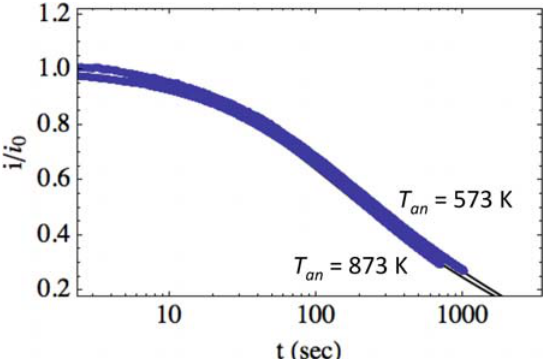
Photocurrent transient relaxation for detectors with base films annealed at T = 573 K and T = 873 K (filled circles) at illumination intensity P = 2.0 mW/cm 2 . an an Experimental data is fit to Equation (11), with the best fits shown as the solid lines. = (573 , 873) K, A = (1 . 5 , 1 . 5) × 10 − 2 s − 1 , B = (3 . 1 , 3 . 5) × 10 − 4 s − 1 For T an